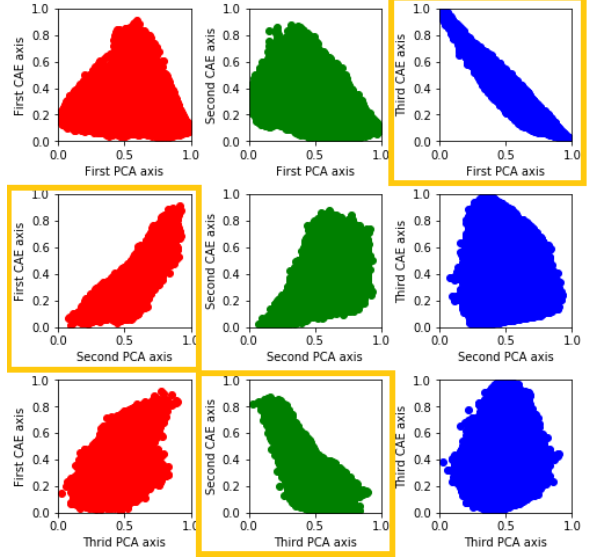
Figure 1. Scatter plot between each axes of PCA and CAE embeddings. The yellow circles surround the combination of matches selected to optimize correlations.